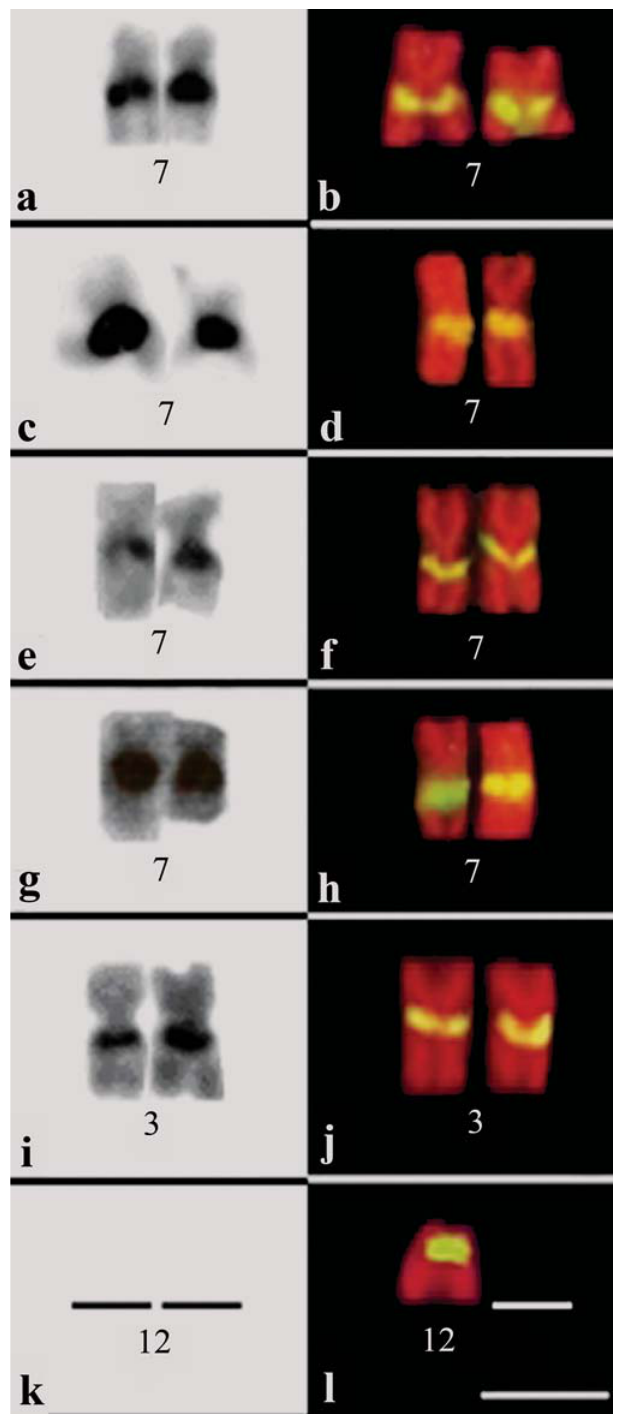
Fig. 3. Chromosome pairs of Serrasalmidae species showing the co-localization of the heterochromatic C-positive band (left side) and 5S rDNA site (right side): a-b ) Serrasalmus elongatus ; c-d ) Serrasalmus maculatus ; e-f ) Serrasalmus cf. rhombeus ; g-h ) Serrasalmus rhombeus ; i-j ) Pygocentrus nattereri ; k-l ) Colossoma macropomum . Numbers indicate the corresponding chromosome pair in the karyotypes of the species. Pair 12 in Colossoma macropomum does not exhibit the conspicuous